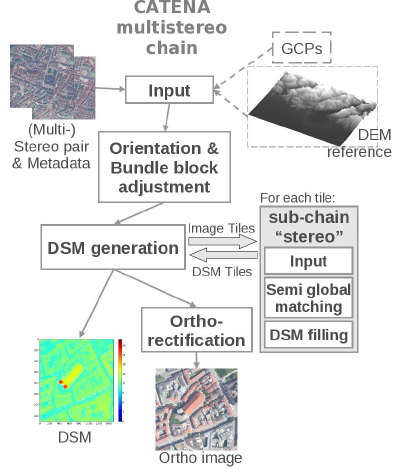
Figure 7: CATENA multistereo chain